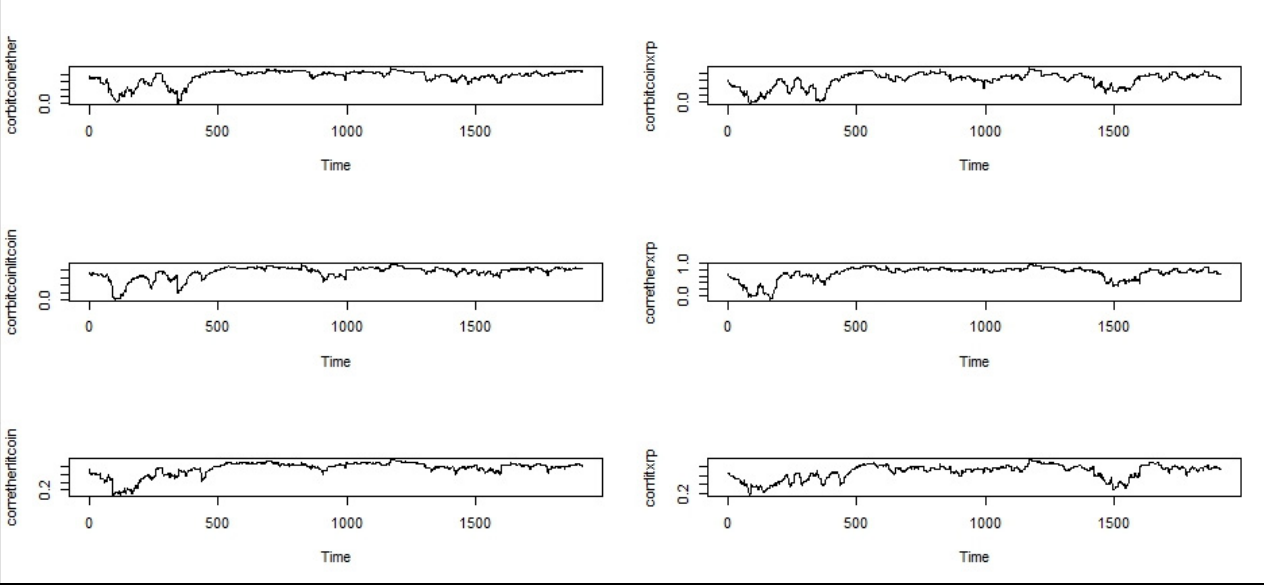
Figure 3. Dynamic Conditional Correlation. Table 12. Mean of DCC of Cryptocurrencies Return.